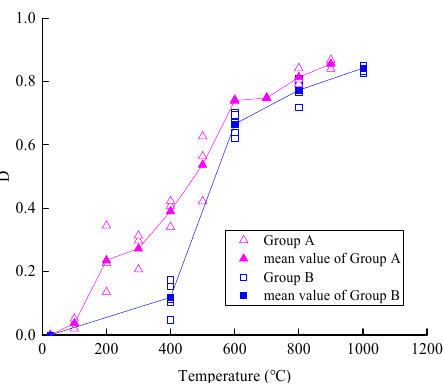
Figure 6. The relationship between damage factors and temperature of high temperature samples.